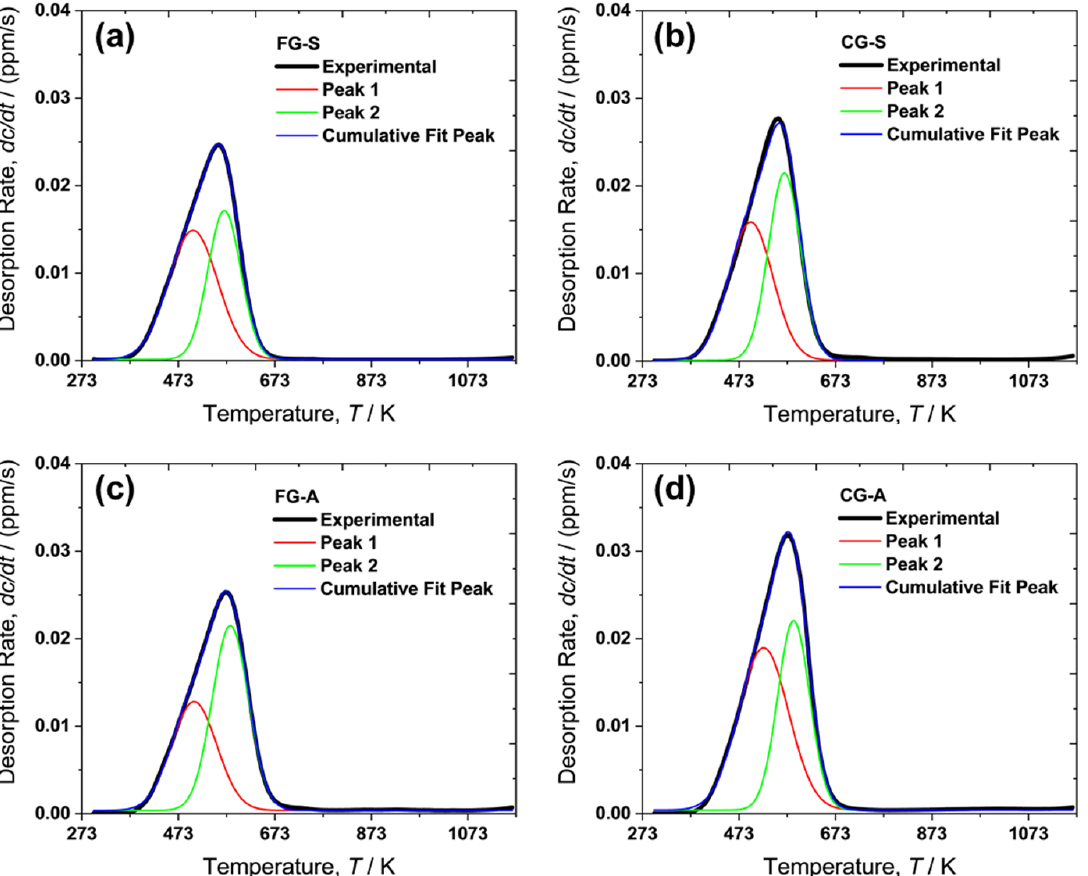
Figure 7. Hydrogen desorption curve of ( a ) FG-S, ( b ) CG-S, ( c ) FG-A, and ( d ) CG-A specimens. The cumulative curve (blue) of the sum of two fitted curves (red and green) match well with the experimental TDS curve (black) in each specimen.